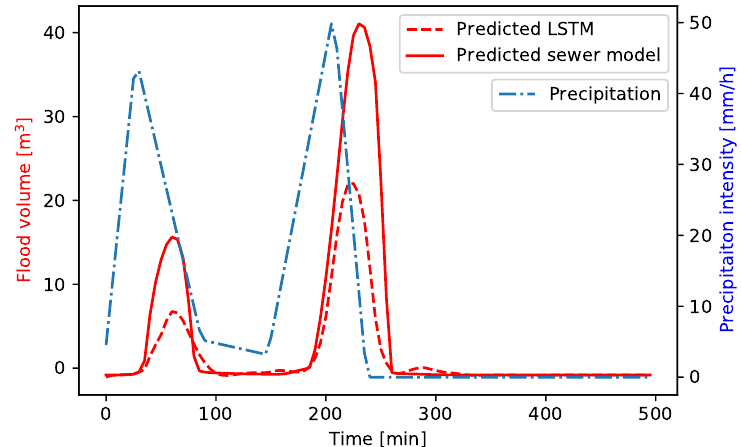
Figure 12. Flood volume time series, for the LSTM network validated on synthetic data, at a manhole in the southeast of the area (NSE =